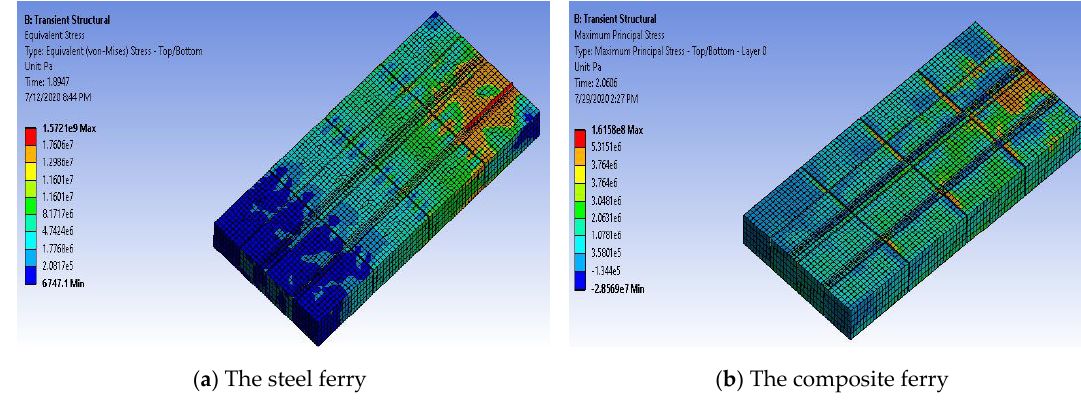
Figure 29. Stresses distribution for case 3.